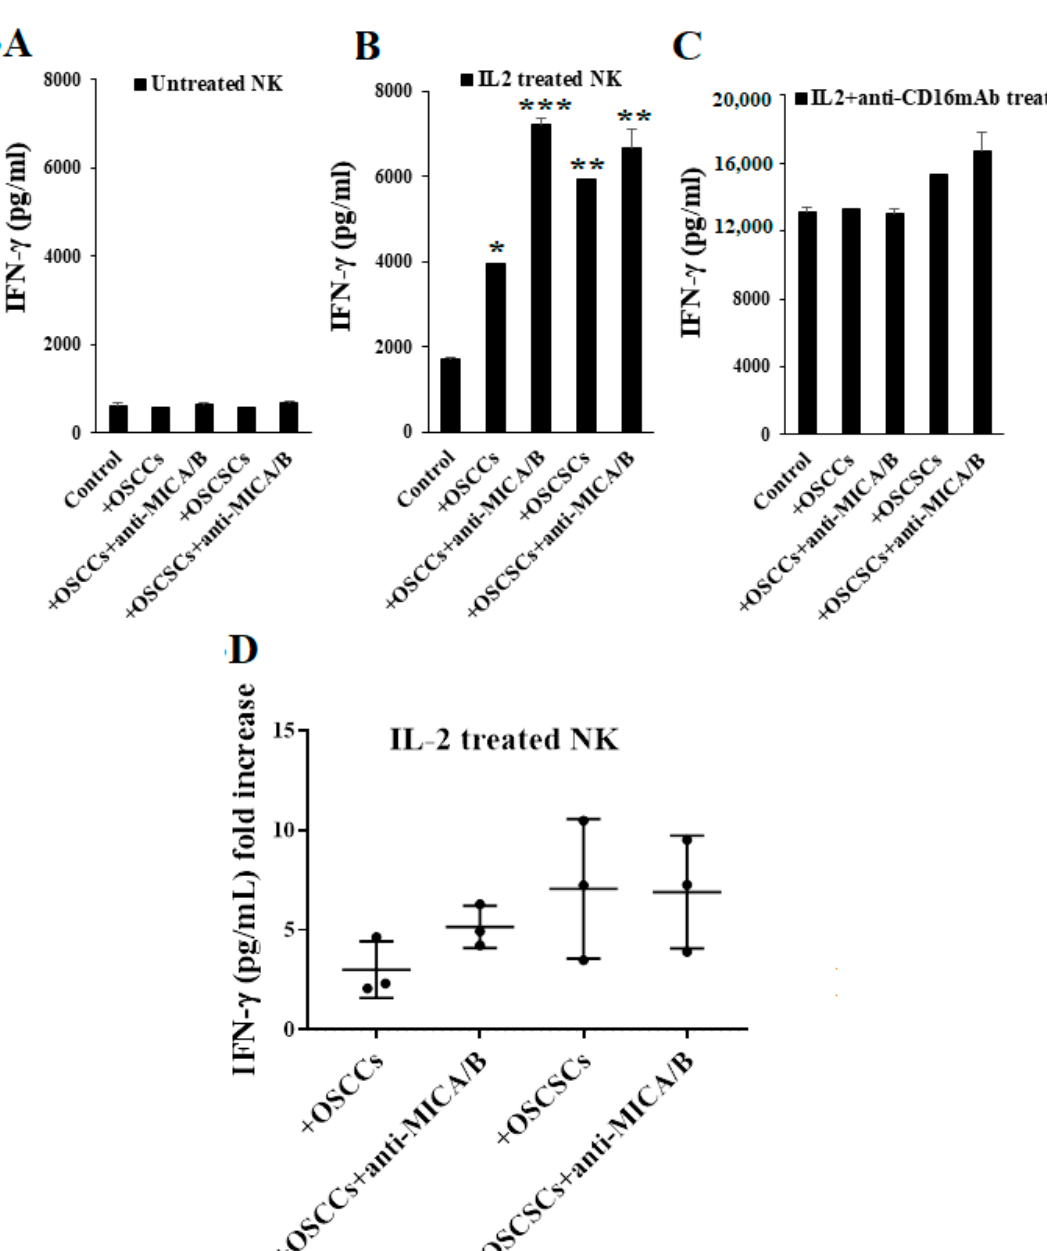
Figure 3. Differentiated tumor cells treated with anti-MICA/B mAb increased IFN- γ secretion of IL-2 activated NK cells. Freshly purified NK cells from healthy individuals were left untreated ( A ), treated with IL-2 (1000 U/mL) ( B ), or treated with a combination of IL-2 and anti-CD16 mAb (3 µg/mL) ( C ) for 18 h. OSCCs and OSCSCs were treated with anti-MICA/B mAb (5 µg/mL) for 18 h, excess unbounded antibodies were removed, and the tumor cells were co-cultured with NK cells. The supernatants were harvested from the co-cultures after 24 h, and the concentrations of IFN- γ were determined using single ELISA ( n = 2) ( A–C ). The ratios of IFN- γ secretion of IL-2 activated NK cells induced by untreated or anti-MICA/B mAb treated oral tumor cells (OSCCs and OSCSCs) were determined as fold increase ( n = 3) ( D ). *** ( p value < 0.001), ** ( p value 0.001–0.01), * ( p value 0.01–0.05).